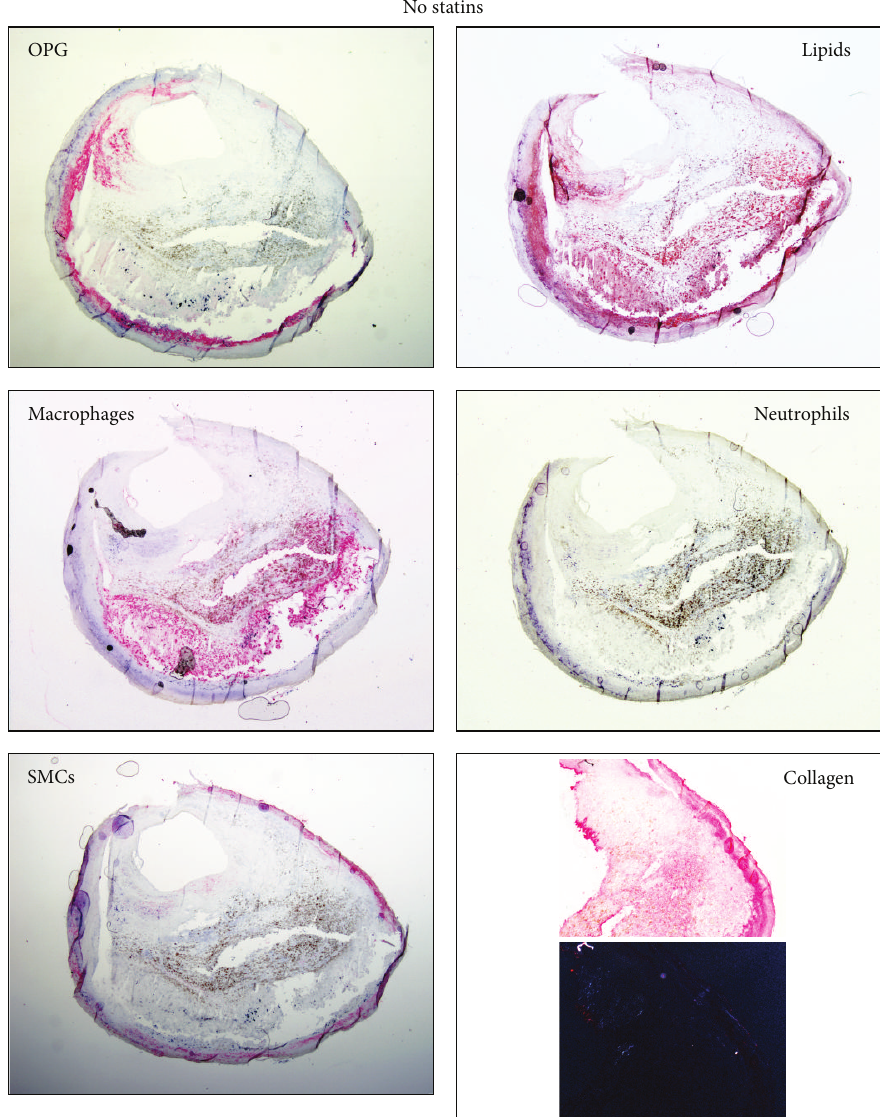
Figure 2: Representative microphotographs of consecutive cryosections from upstream regions of carotid plaques from patients without statins. Staining for osteoprotegerin (OPG), lipids, macrophages, neutrophils and smooth muscle cells (SMCs), and collagen is